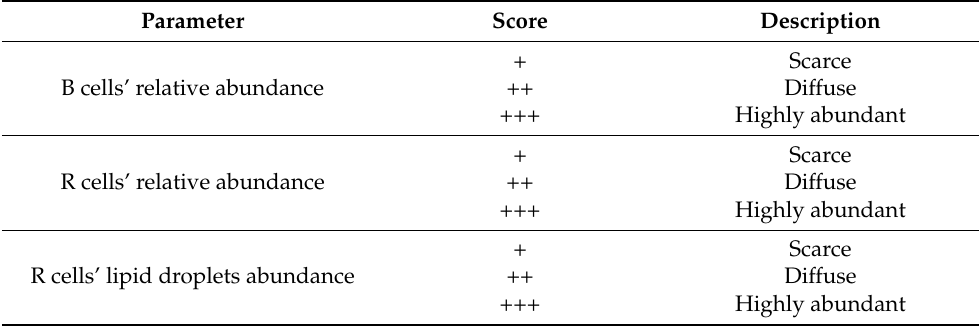
Table 2. Score-assignment criteria for B and R cells’ relative abundance and R cells’ lipid droplets abundance, measured in histological sections from the middle portion of hepatopancreas